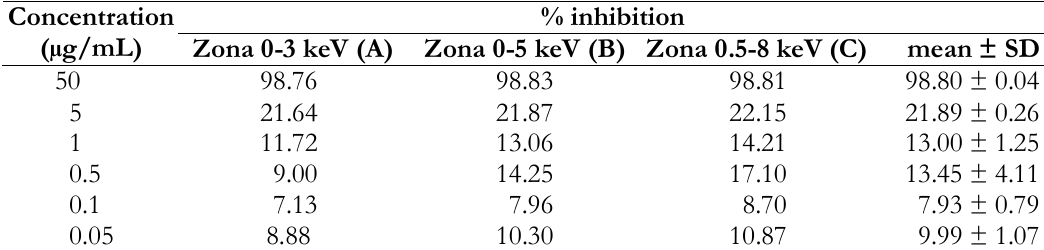
Table I. Inhibition of the growth (%) of chloroquine-resistant P. falciparum (FCR-3) due to administration of 8-hydroxyisocapnolactone-2  3  -diol on the three measurement zones